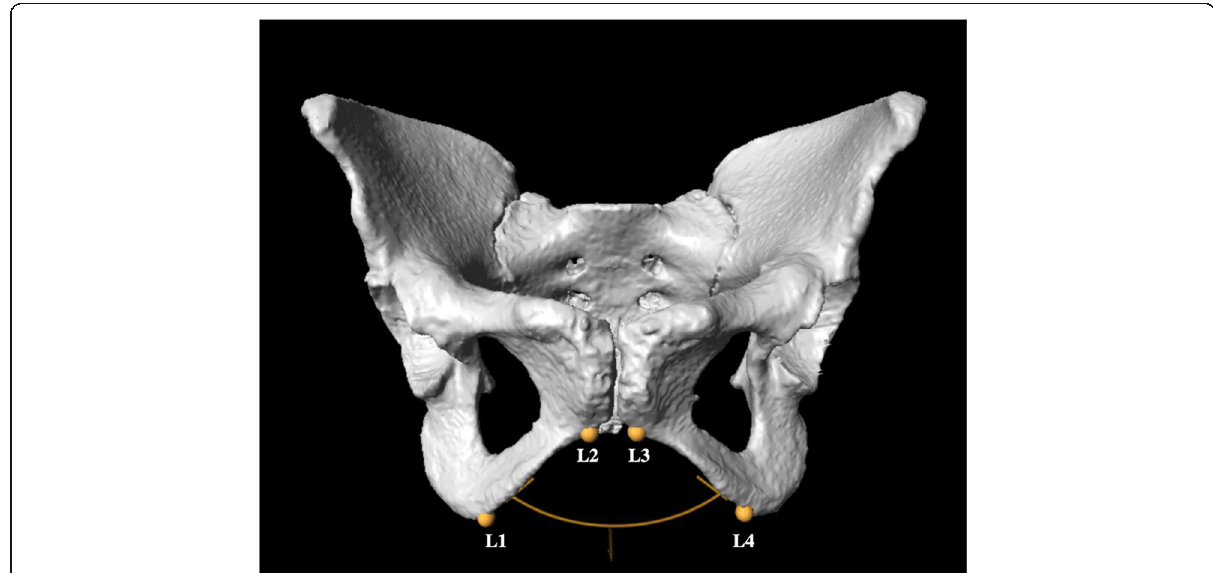
Fig. 1 Pelvic image showing subpubic angle measurement using the Checkpoint (Method 1). Landmarks definition in Table